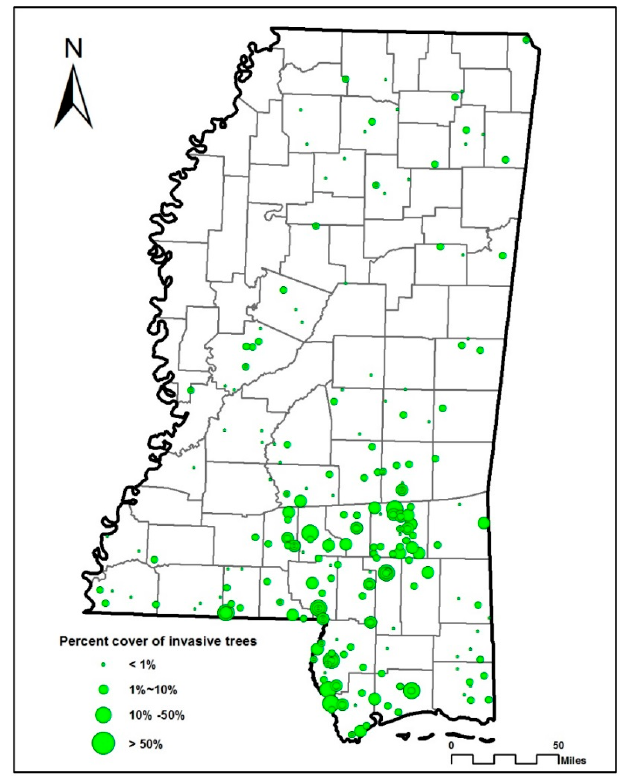
Figure 1. Location and percent cover of invasive tree species per Forest Inventory and Analysis (FIA) plot on Mississippi forestland based on ArcGIS.